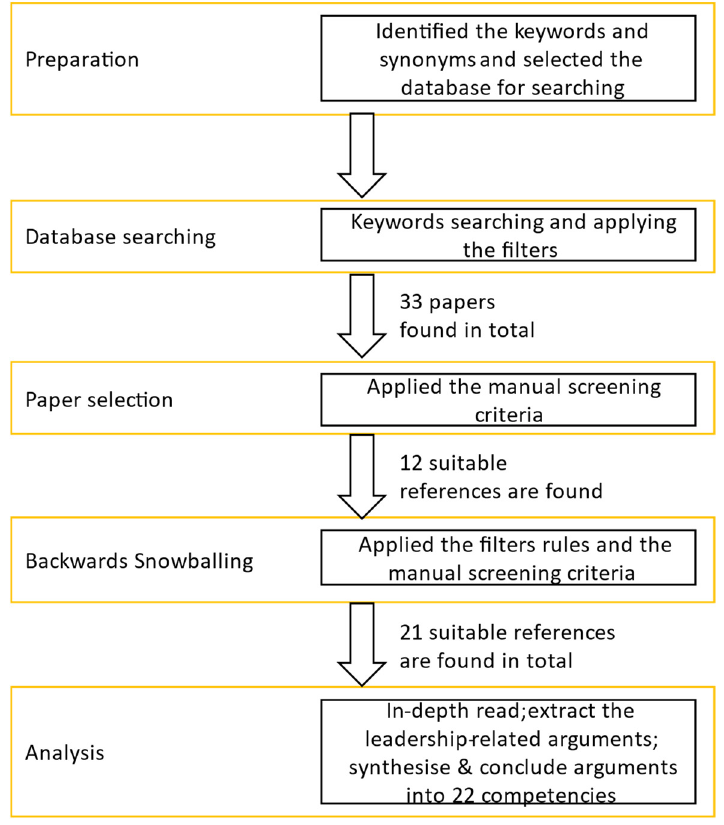
Figure 2. Overall study process.